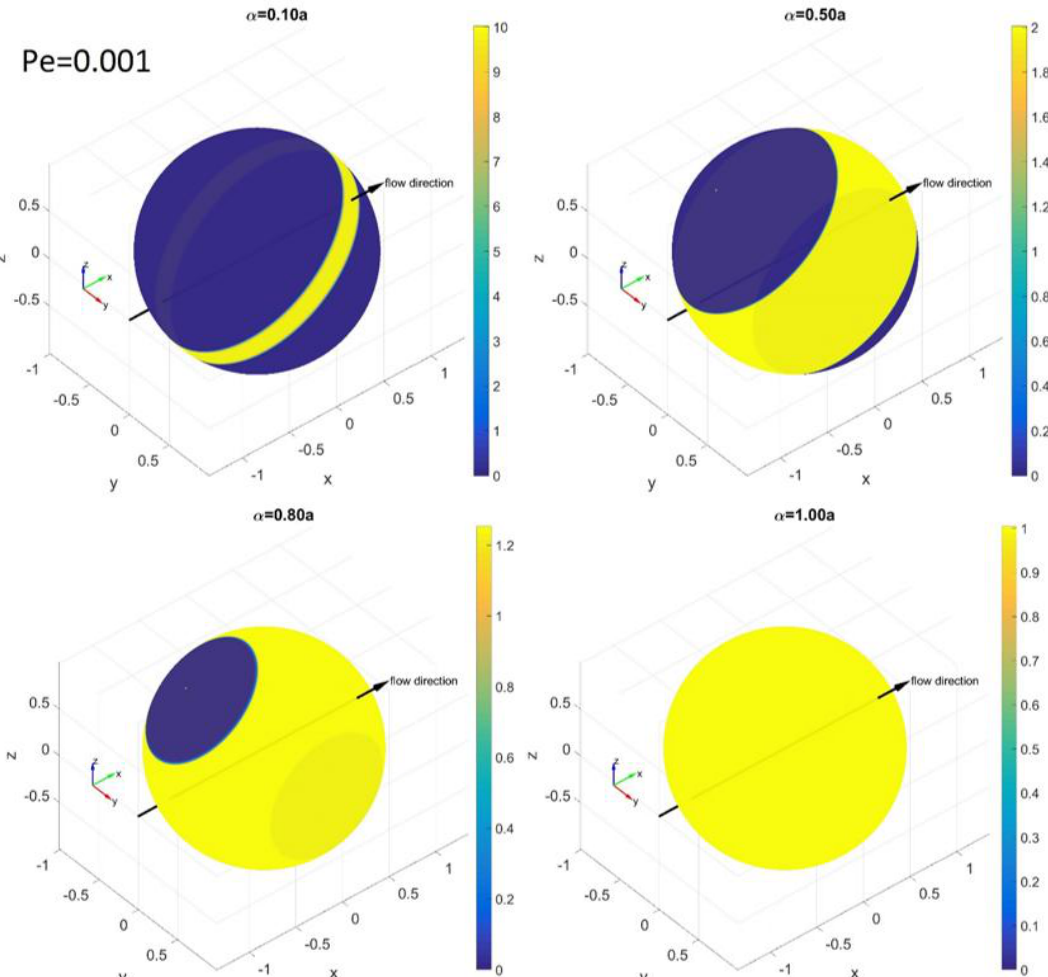
Figure 7. Simulation results for the PDF( θ , ϕ ) on the spherical surface of the tips of a rod at Pe = 0.001 with α / a = 0.1, 0.5, 0.9 and 1.0. The color bars represent the probability density levels of each PDF from yellow (highest probability) to dark blue (lowest probability) (color online).